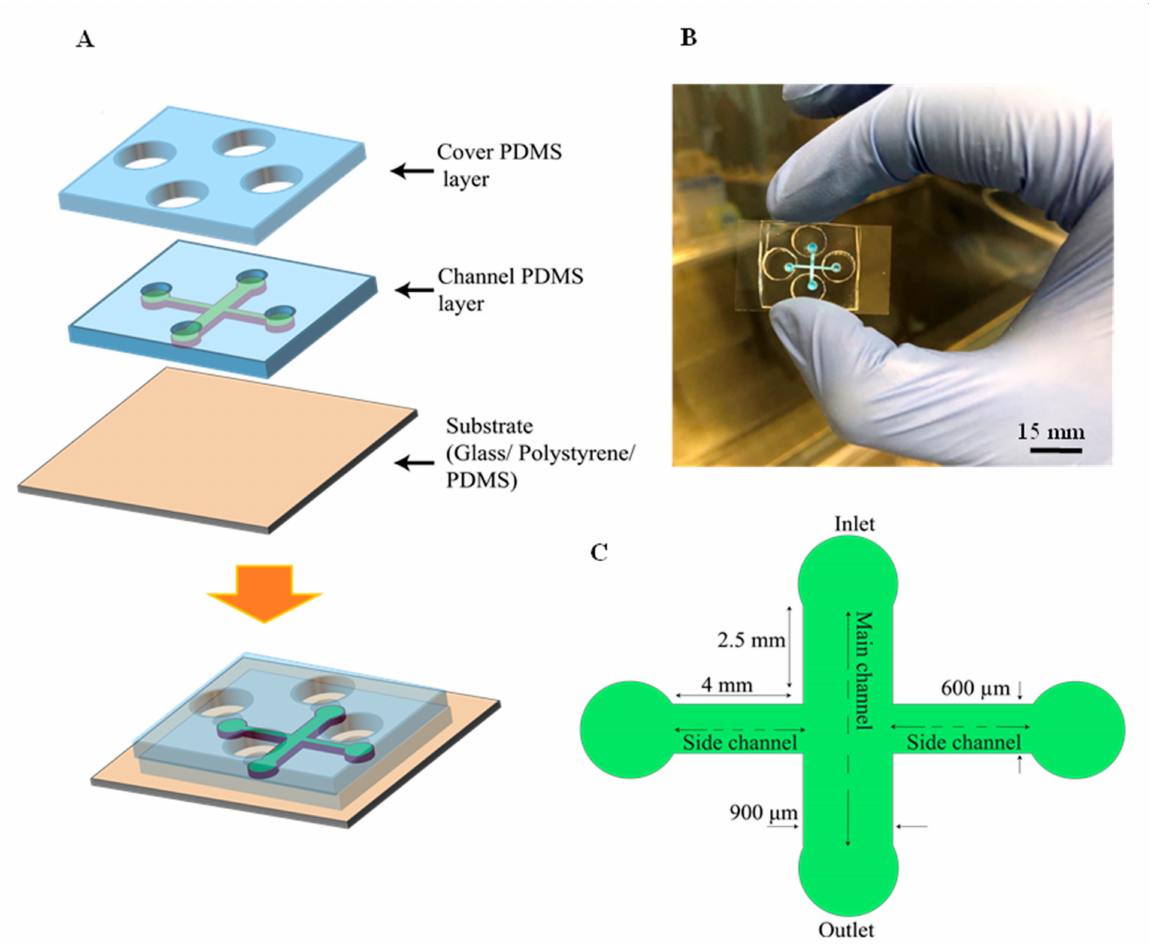
Figure 1. Schematic of the microfluidic device. ( A ) exploded view of the two PDMS layers that bonded on the substrate. ( B ) Actual photography of the microfluidic device with the microchannels filled with red dye, 3D view, scale bar = 15 mm. ( C ) Geometrical configuration, top